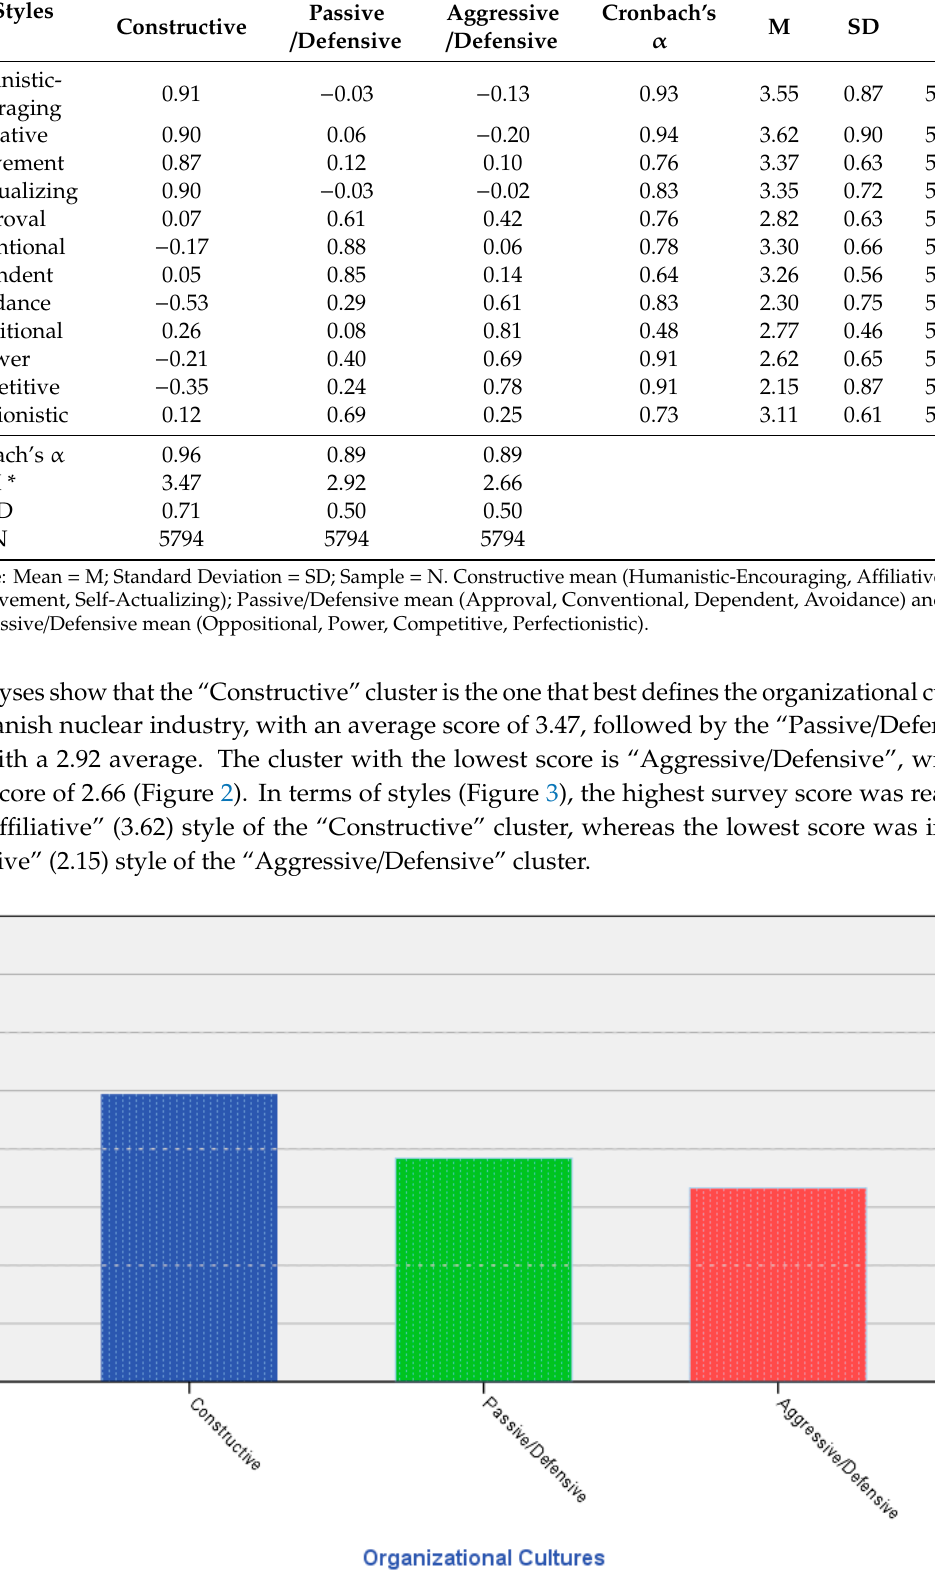
Figure 3. OCI Styles averages.